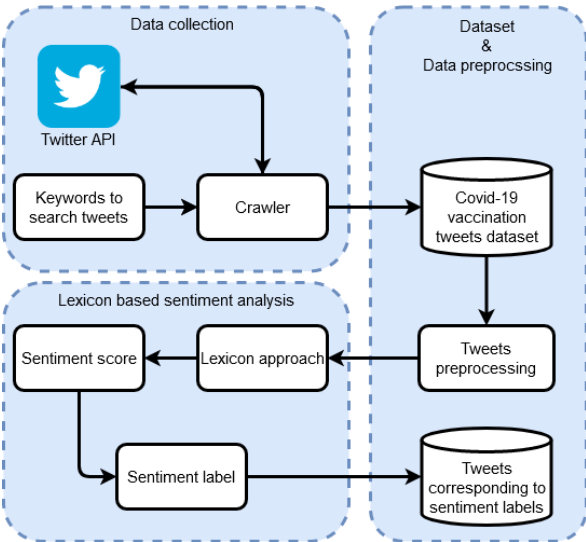
Figure 3. Lexicon-based approach for sentiment analysis.